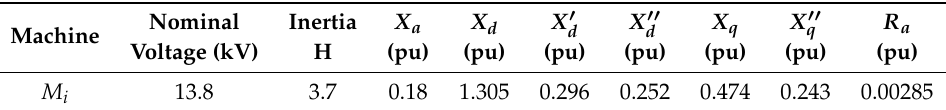
Table A1. Machine parameters.